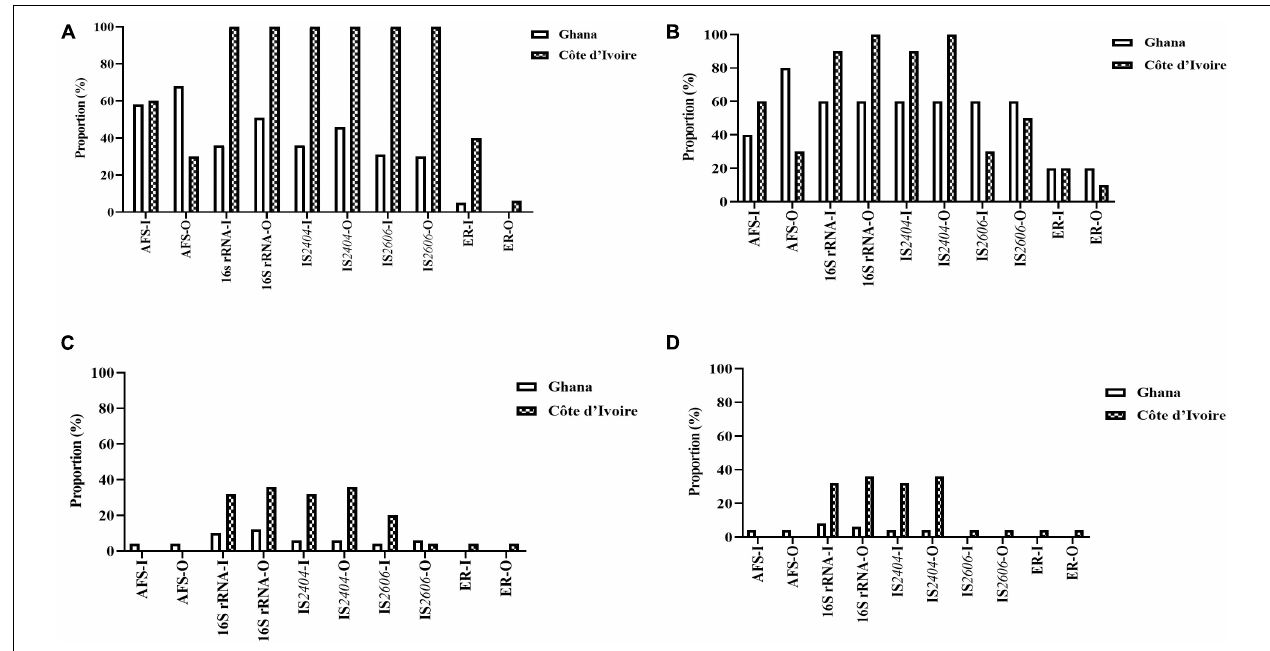
FIGURE 3 | Positivity rate of the different detection methods of M. ulcerans, (A) water, (B) biofilm, (C) detritus, and (D) soil samples collected from Ghana and Cote d’Ivoire. I, inner section of the water body; O, riparian zone of the water